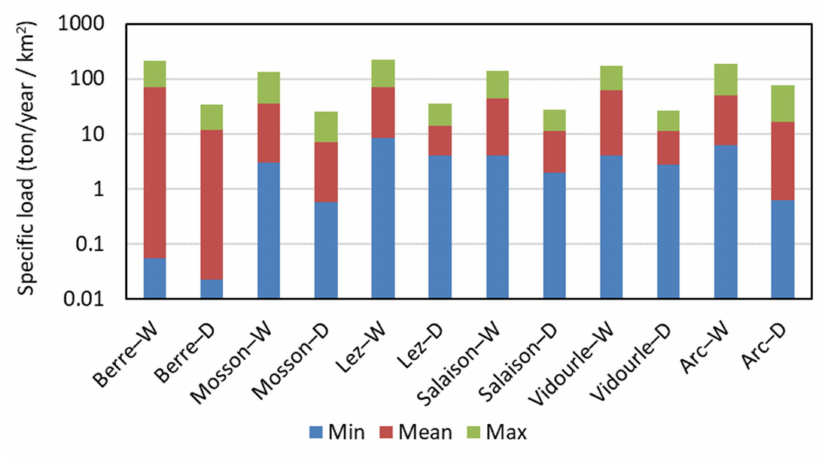
Figure 12. Minimum, average and maximum values of the specific load (ton/year/km 2 ) of total suspended solids (TSS) calculated on the six watersheds by the flow-weighted mean concentration method (FWMC, indicated by W on the plot) and the flow duration rating curve method (FDRC, indicated by D).